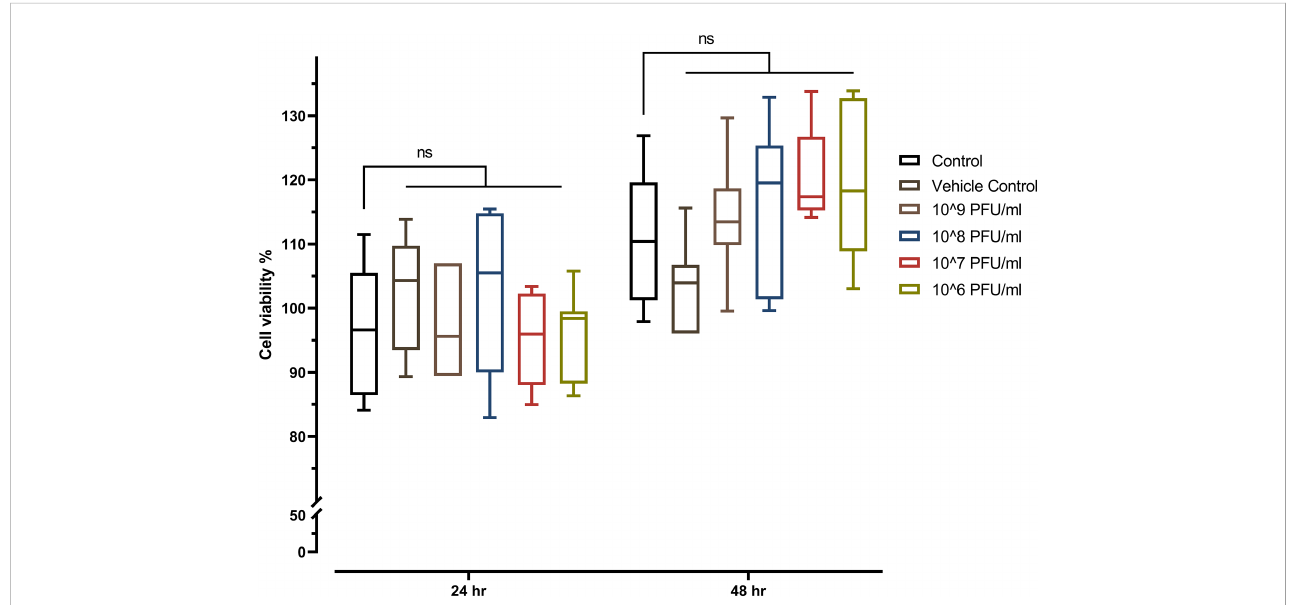
FIGURE 7 MTT assay of phage-treated HSF cells viability seeded at a density of 8 × 10 3 cells/well in a 96-well cell culture plate. The mean percentage of viable cells after exposure to four different concentrations of phage vB_Kpn_ZCKp20p for 24 h and 48 h were statistically compared to the mean viability of control cells (untreated cells). The vehicle control was SM buffer (the phage vehicle) diluted in DMEM media corresponding to the prepared phage dilutions. The mark ‘ ns ’ indicates statistically non-signi fi cant differences ( P >